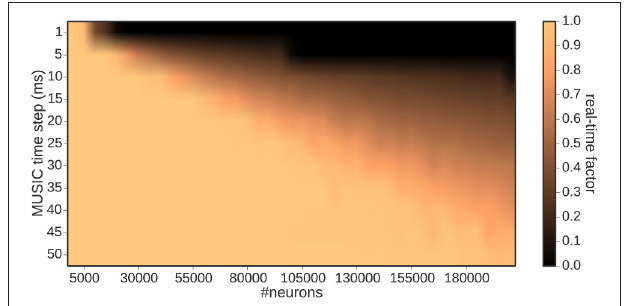
FIGURE 4 | Real-time factor as a function of the MUSIC time step and number of encoding neurons.